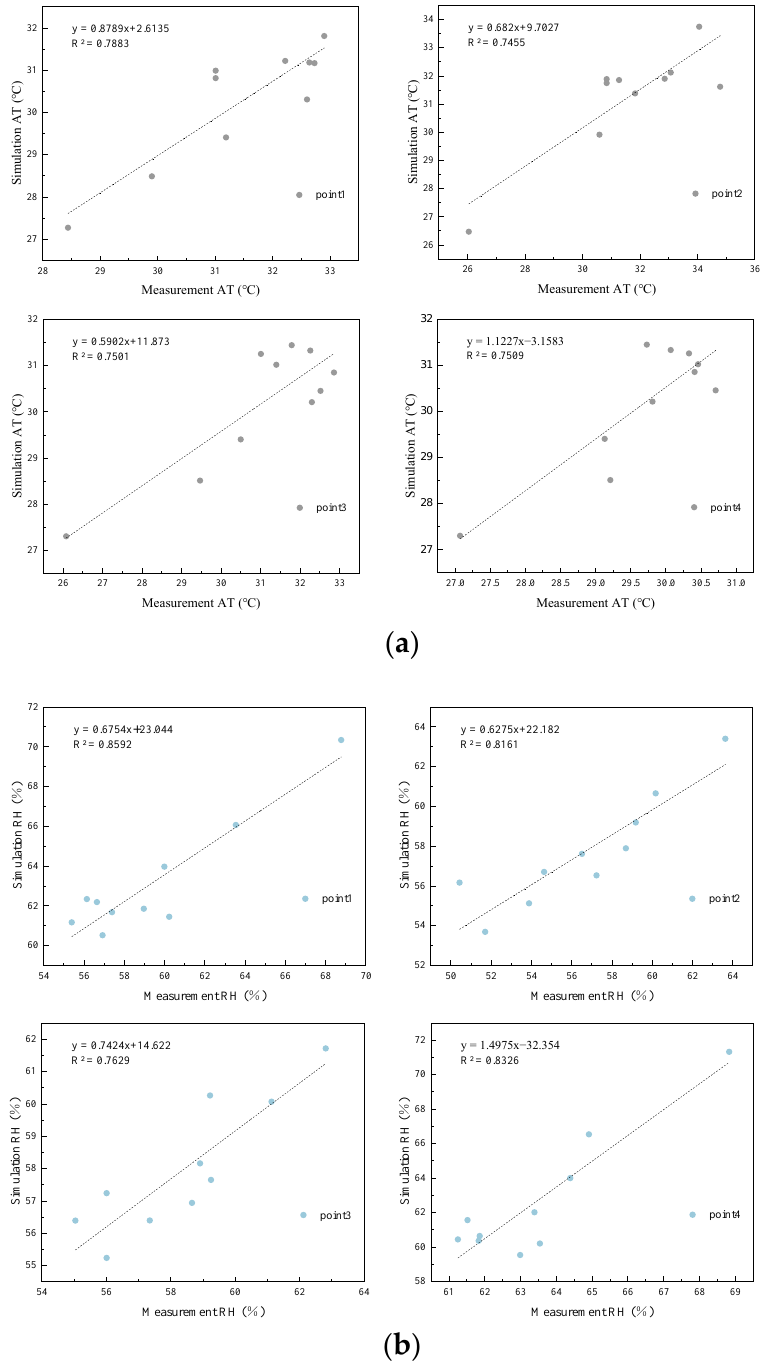
Figure 5. Linearity between the simulated data and the measured data: ( a ) AT; ( b ) RH.